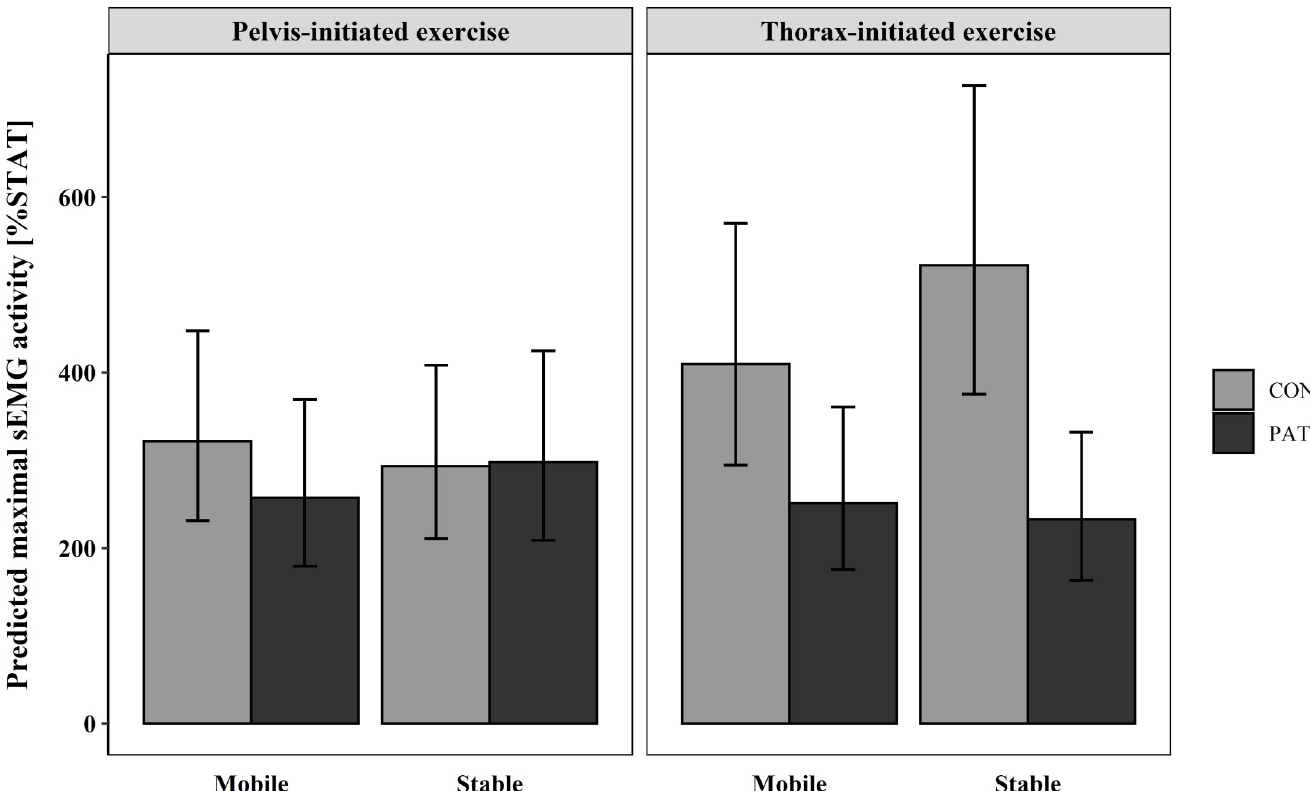
Fig 4. Predicted maximal sEMG activity and confidence level of each subgroup in M. erector spinae. CON = healthy participants, PAT = people after stroke, % STAT = percentage of maximal muscle activity relative to static sitting on the stable seat.